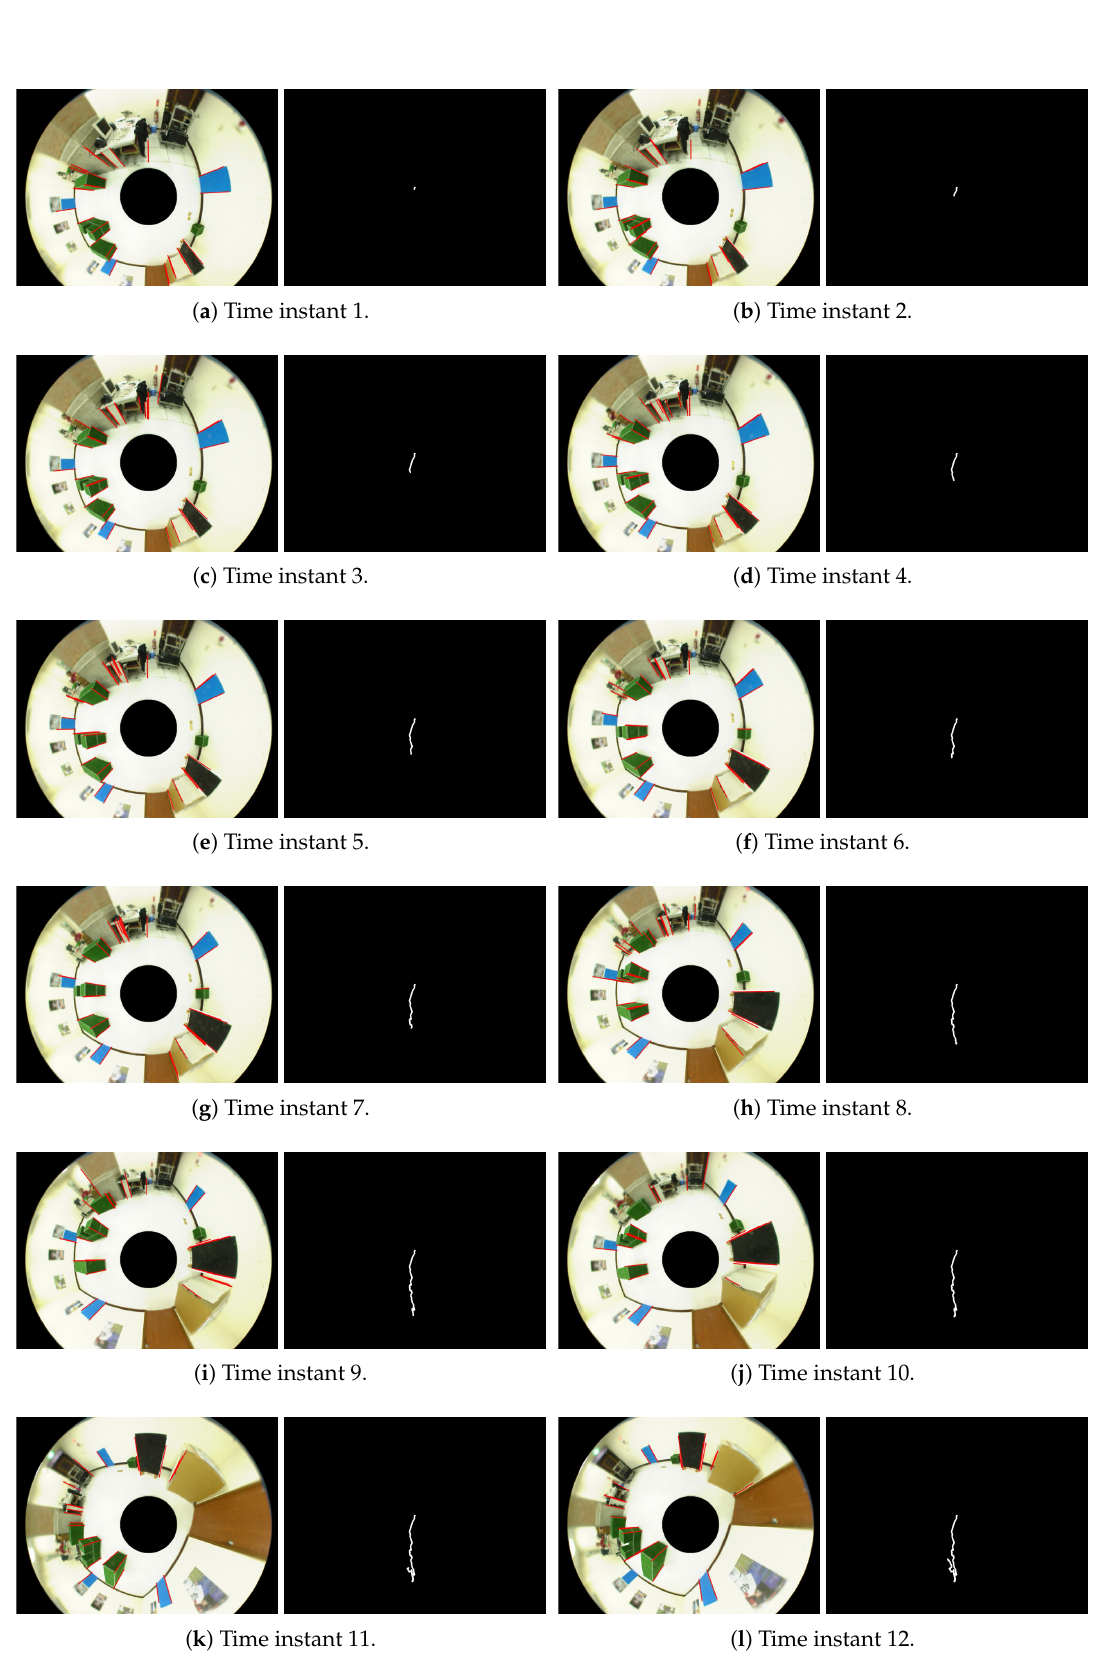
Figure 13. The trajectory of the mobile robot navigation in the indoor environment. It is derived from the proposed self-localization technique using the vertical lines in the space and the corresponding base points on the ground